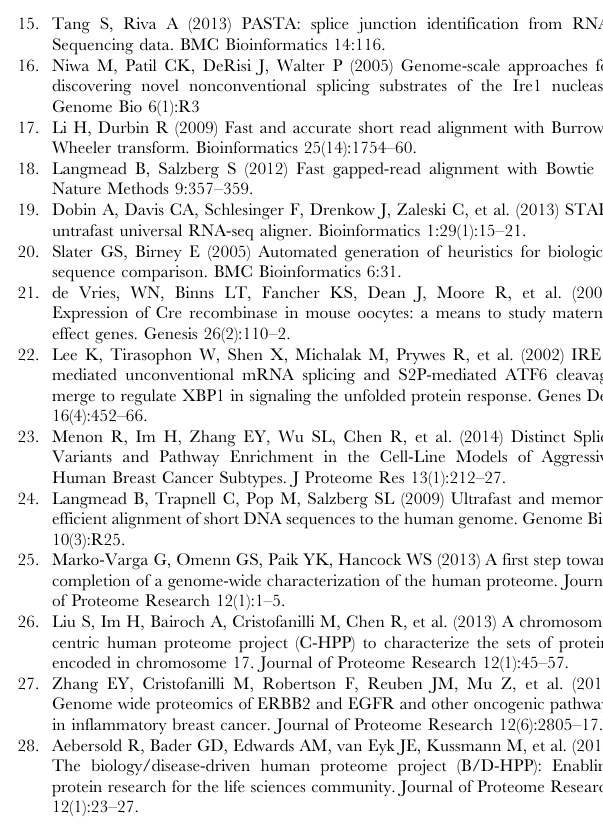
Table S1 Reads mapped by the RSW pipeline on Xbp1’s